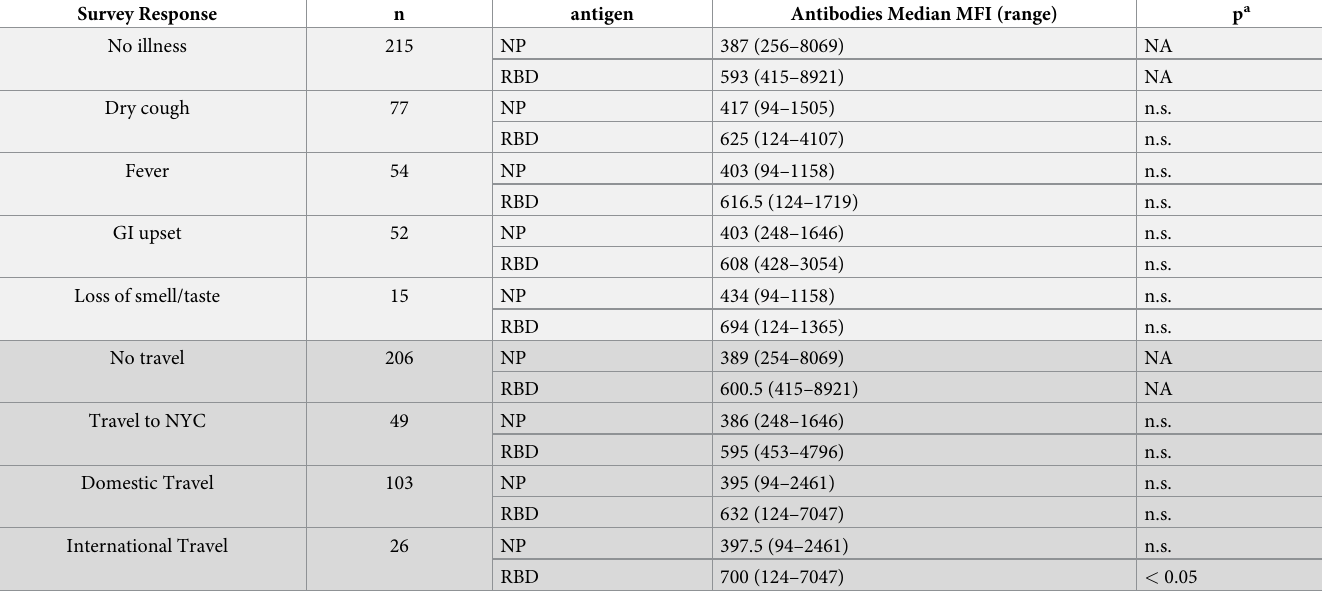
Table 5. Comparison of NP and RBD-specific serum IgG antibodies in healthy volunteers by illness and travel history between January and May 2020. Survey